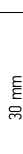
Fig. 1. Fabrication flow diagram of embedded channel in LTCC substrate (source: own edition) 30